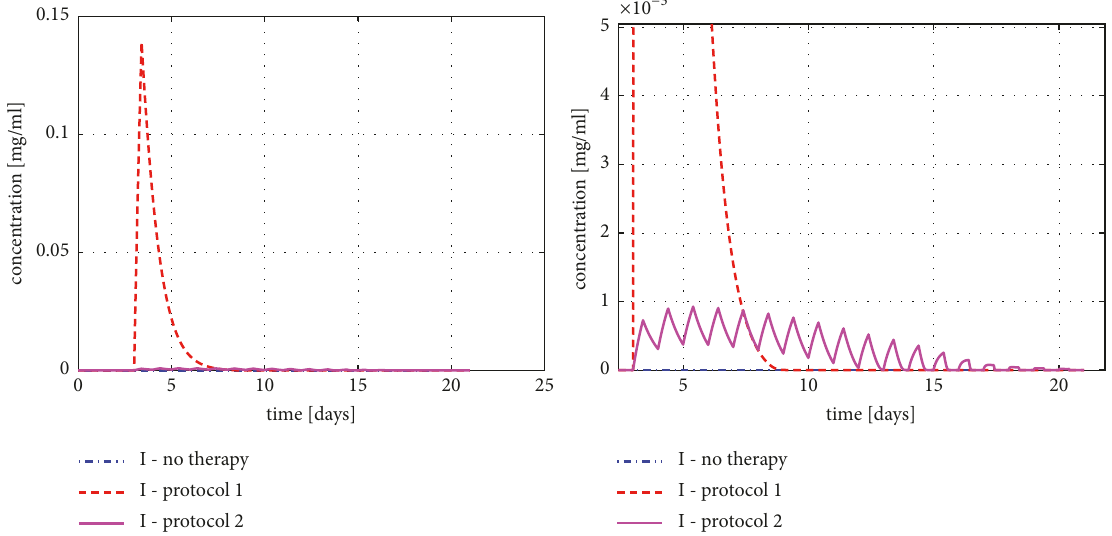
Figure 5: Concentration of the inhibitor ( 𝐼 ) in the case of various therapies on two different